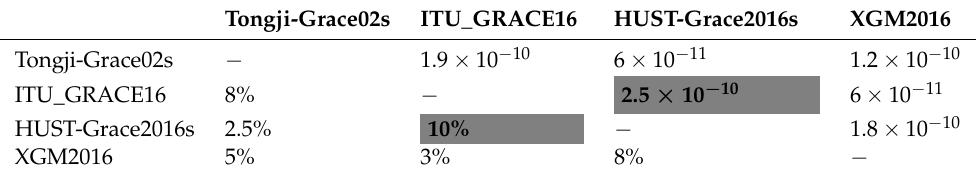
of the WEB page of the International Center for Global Earth Models (ICGEM) at http://icgem.gfz- potsdam.de/tom_longtime. Strictly lower triangular matrix: maximum values of the percent error ψ computed from Equation (6) by assuming the figures in the strictly upper triangular matrix for the uncertainty in C 2,0 . The semimajor axis a and the inclination I of CL were allowed to vary within a range of a CL = 12,270 ± 20 km, I CL = 70.16 ± 0.5 deg, respectively. Cfr. with Figure A1.